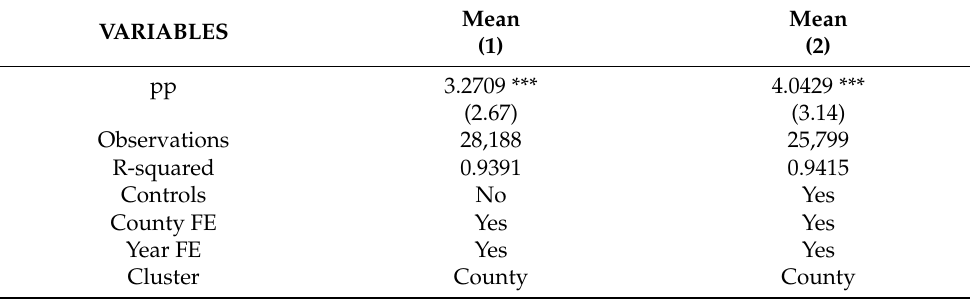
Table 3. The impact of the CCU policy on air pollution.